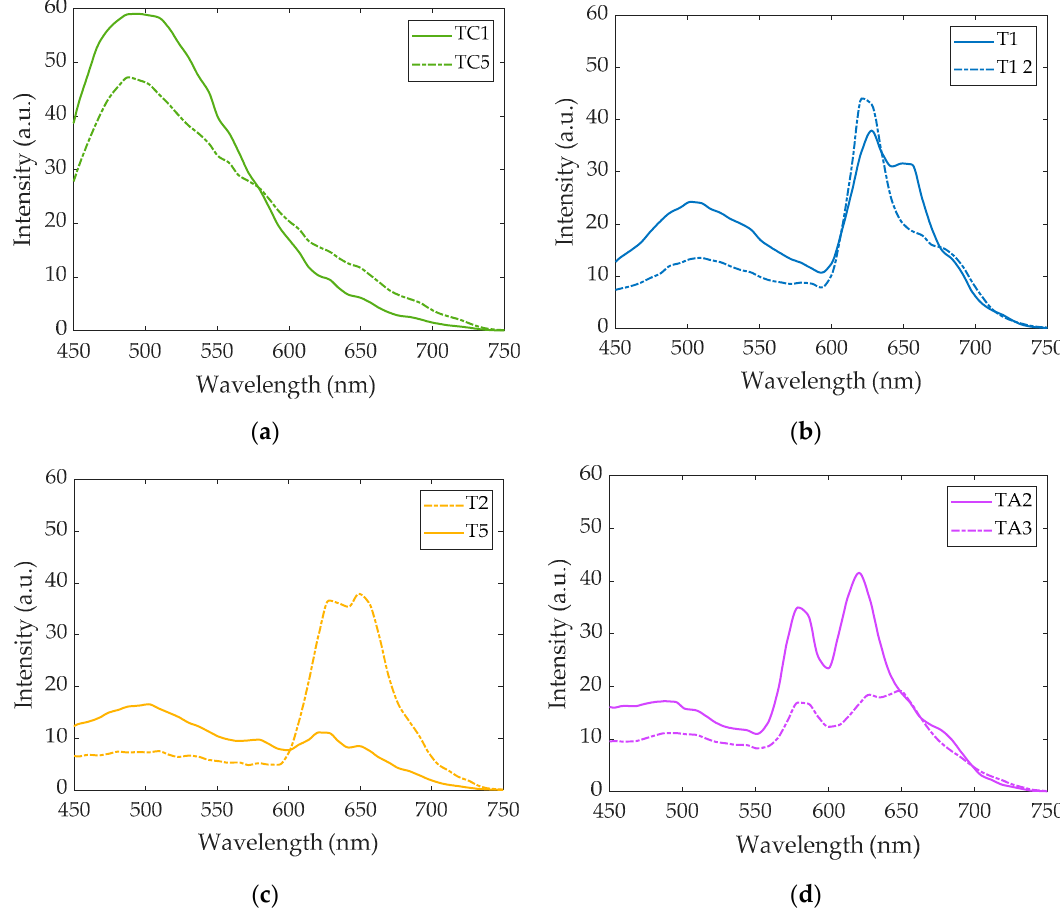
Figure 2. Intensity vs. wavelength (average curves) computed from autofluorescence images of samples ( a ) TC1 and TC5 (healthy subjects); ( b ) T1 and T1_2 (HbH disease); ( c ) T2 (SEA heterozygous deletion) and T5 (3,7 kb heterozygous deletion); ( d ) TA2 and TA3 (iron deficiency).